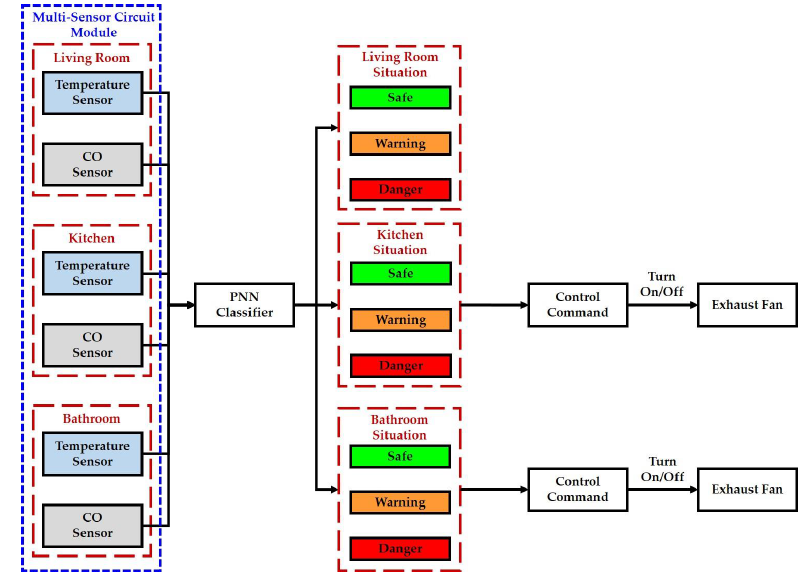
Figure 14. Block diagram of the intelligent fire detection and alarm algorithm.